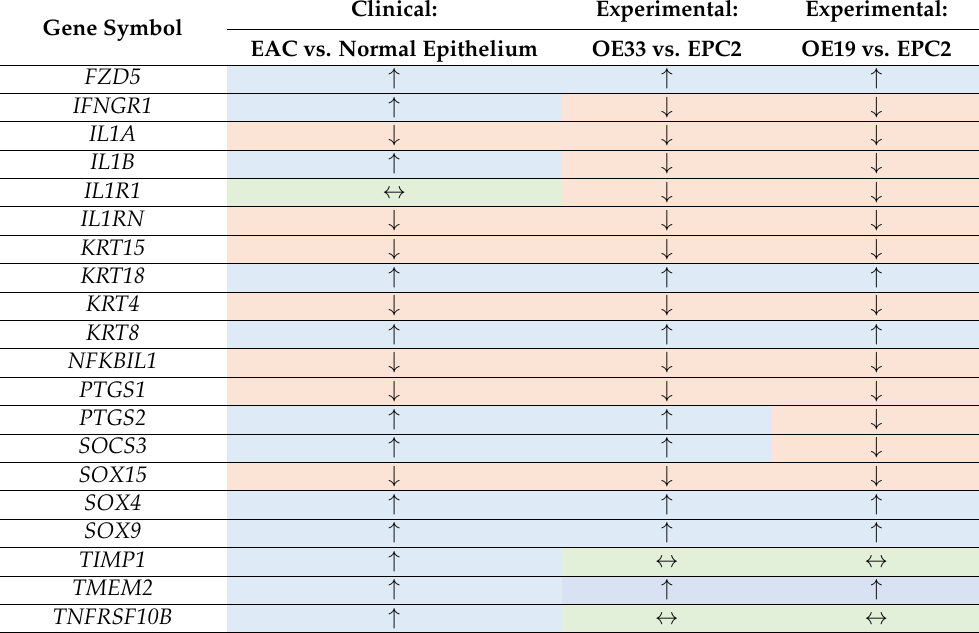
Table 4. Summarized comparison of gene expression profiles observed between in silico analysis of human esophageal adenocarcinoma (EAC) biopsies vs. normal squamous epithelium and wild type untreated OE33 and OE19 cells normalized to EPC2 cells. An arrow up ( ↑ ) and blue background indicate significant upregulation; an arrow down ( ↓ ) and pink background indicate significant downregulation; and a double-sided arrow ( ↔ ) and green background indicate no changes in mRNA